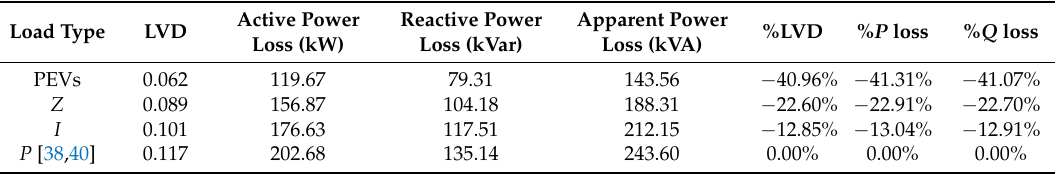
Table 7. Comparison of load voltage deviation (LVD), total active power loss and total reactive power